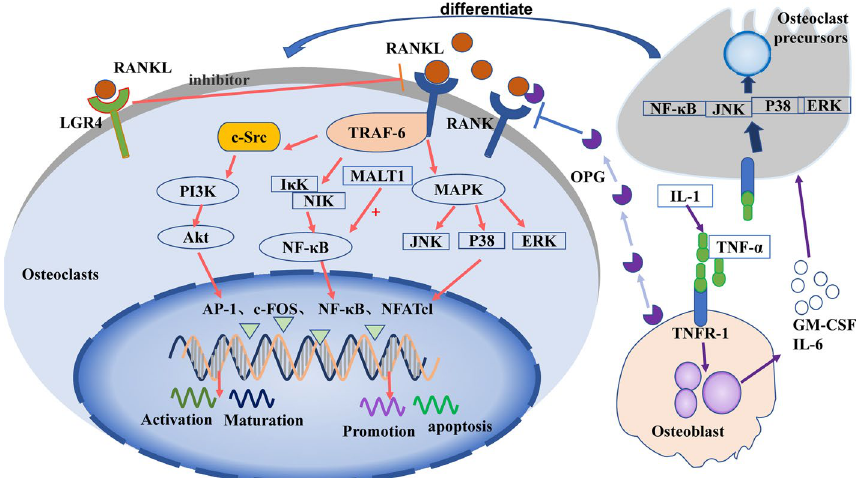
Fig. 2 Signaling pathways in the control of osteoclast differentiation and